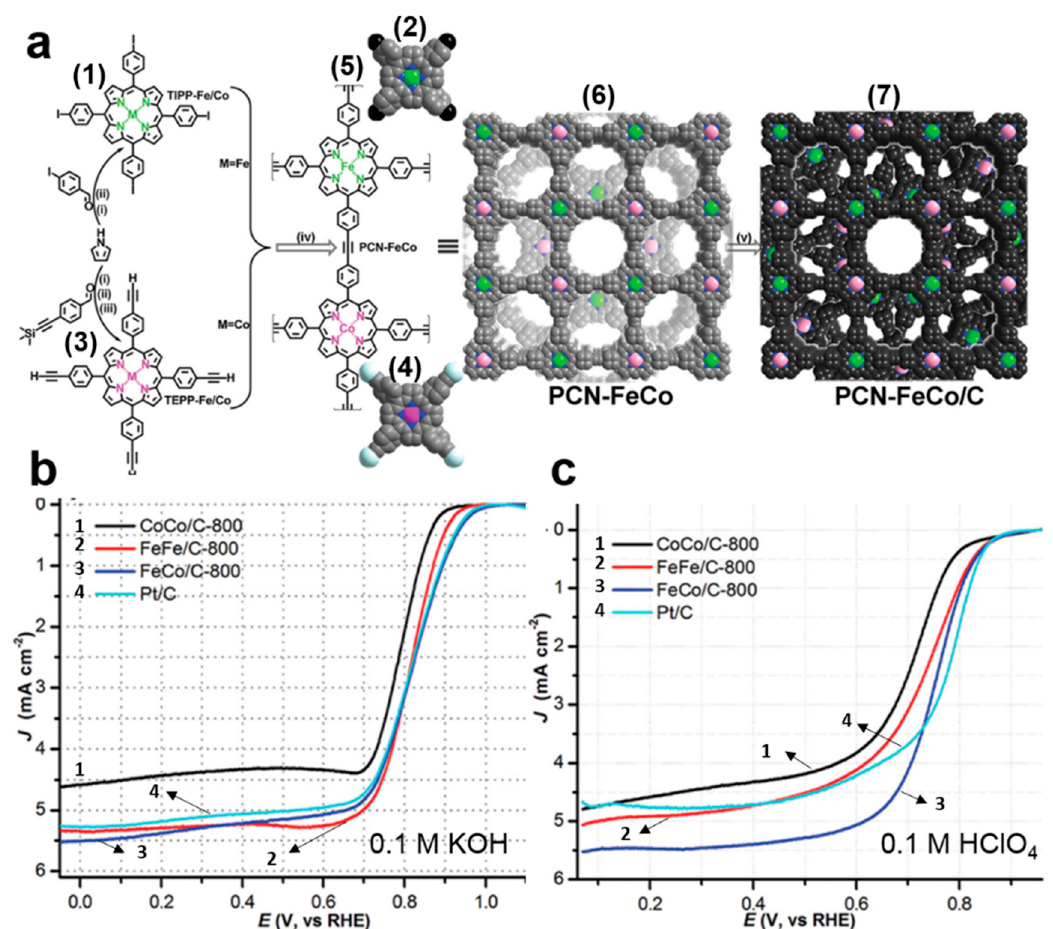
Figure 11. ( a ) Synthesis representation of porous covalent network (PCN)–FeCo/C by carbonization. Monomers: (1,2) TIPP–M, and (3,4) TEPP–M (M = Fe, Co). (5,6) porphyrinic conjugated network PCN–FeCo, and (7) the PCN–FeCo/C product. The reagents and conditions were: (i) propionic